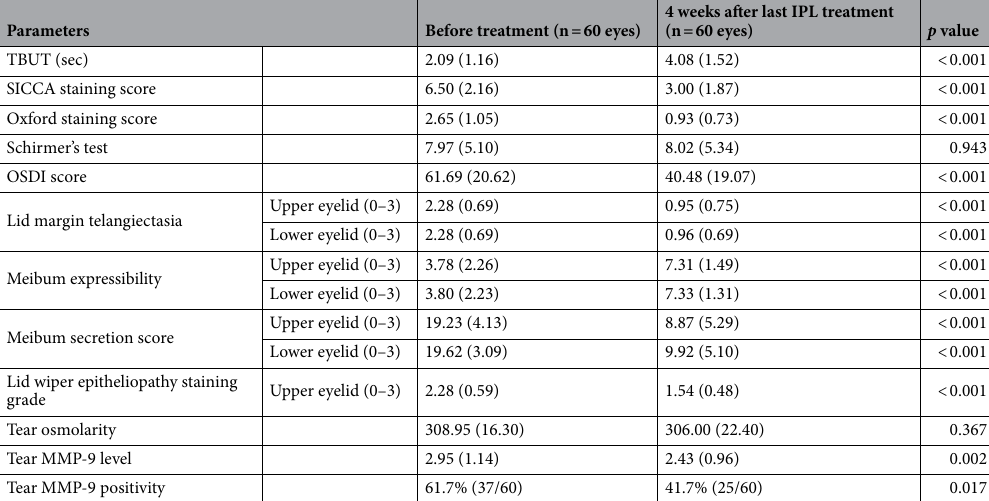
Table 1. Comparison of clinical signs and symptoms before treatment and 4 weeks after the last treatment of intense pulsed light (IPL) regardless of filter type (590-nm or acne filter) in patients with moderate to severe meibomian gland dysfunction. Results are presented as mean (standard deviation). IPL, intense pulsed light; TBUT, tear film break-up time; SICCA, Sjögren’s International Clinical Collaborative Alliance; OSDI, ocular surface disease index; MMP-9, matrix